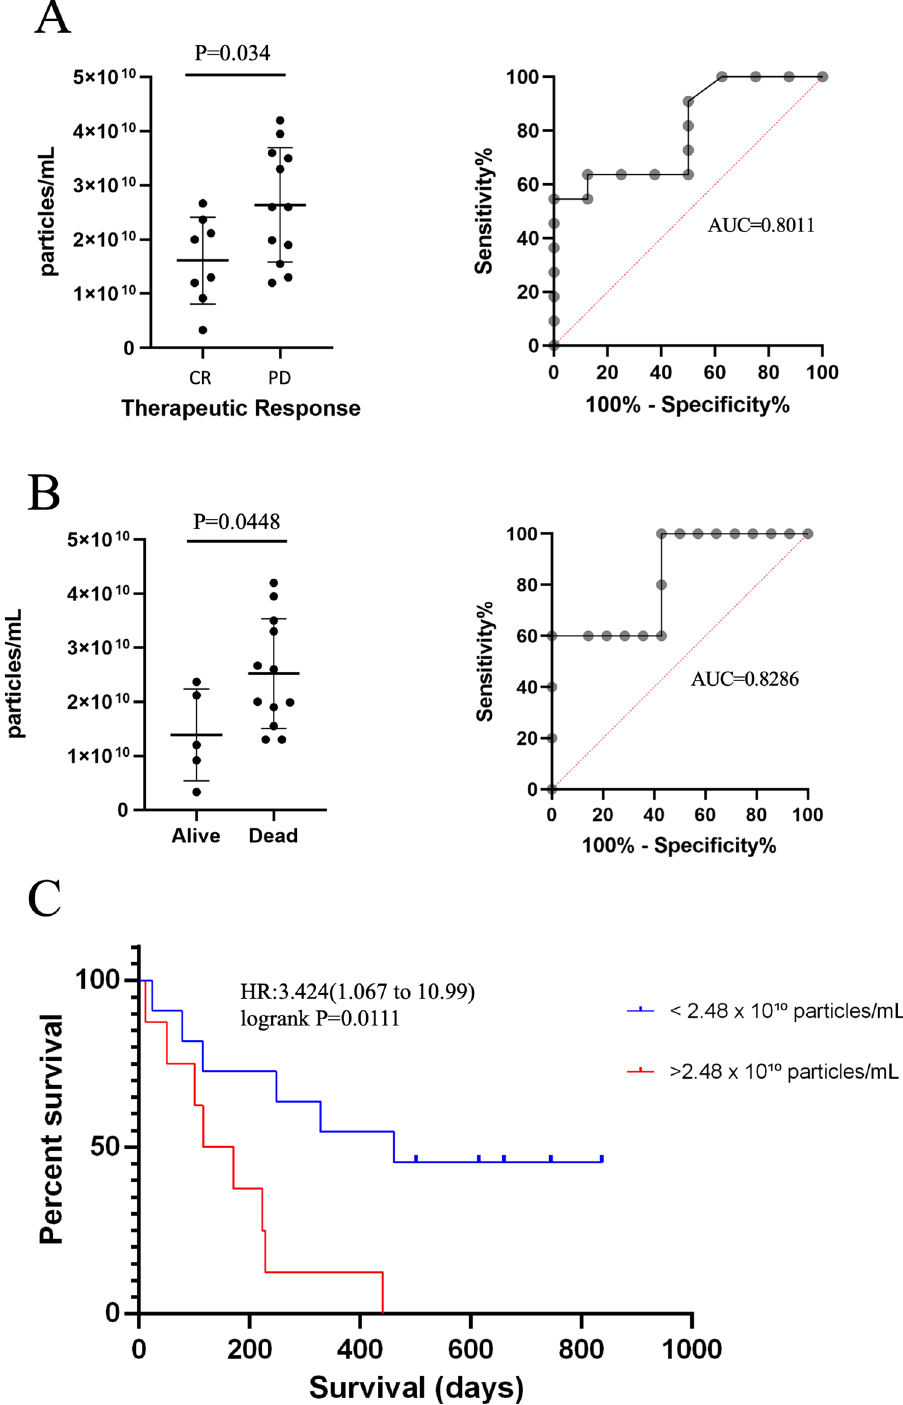
Figure 3. Serum SEVs at the diagnosis predicted the response to chemotherapy. ( A ) Higher concentration of SEVs in PD group when compared to CR group ( P = 0.034) and ROC curve using the concentration of SEVs for therapeutic response (AUC = 0.8011 and P = 0.0287). ( B ) Higher concentration of SEVs in dogs that died due lymphoma compared to dogs that stayed alive ( P = 0.0448) and ROC curve for survival (AUC = 0.8286 and P = 0.0332). ( C ) Kaplan Meier survival analysis for SEVs concentration with 2.48 × 10 10 particles/ml cut-off point (log rank P =